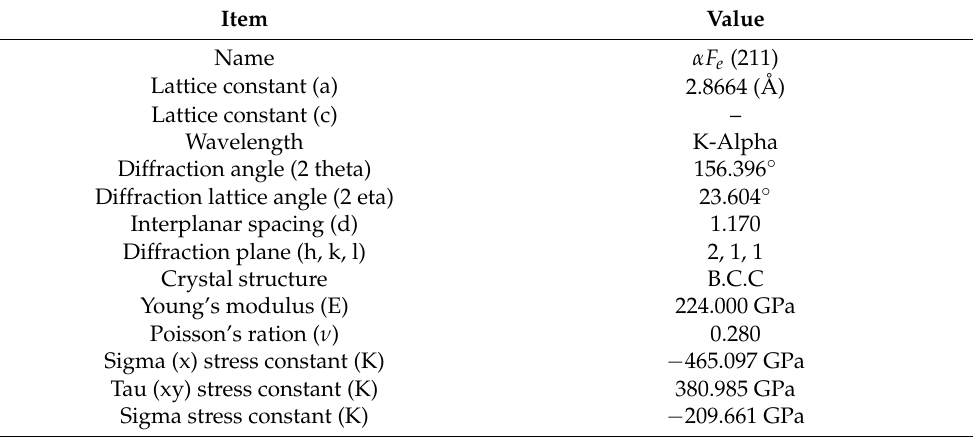
Table 3. Stress-free data for AISI in the PULSTEC μ -X360n X-ray diffractometer .